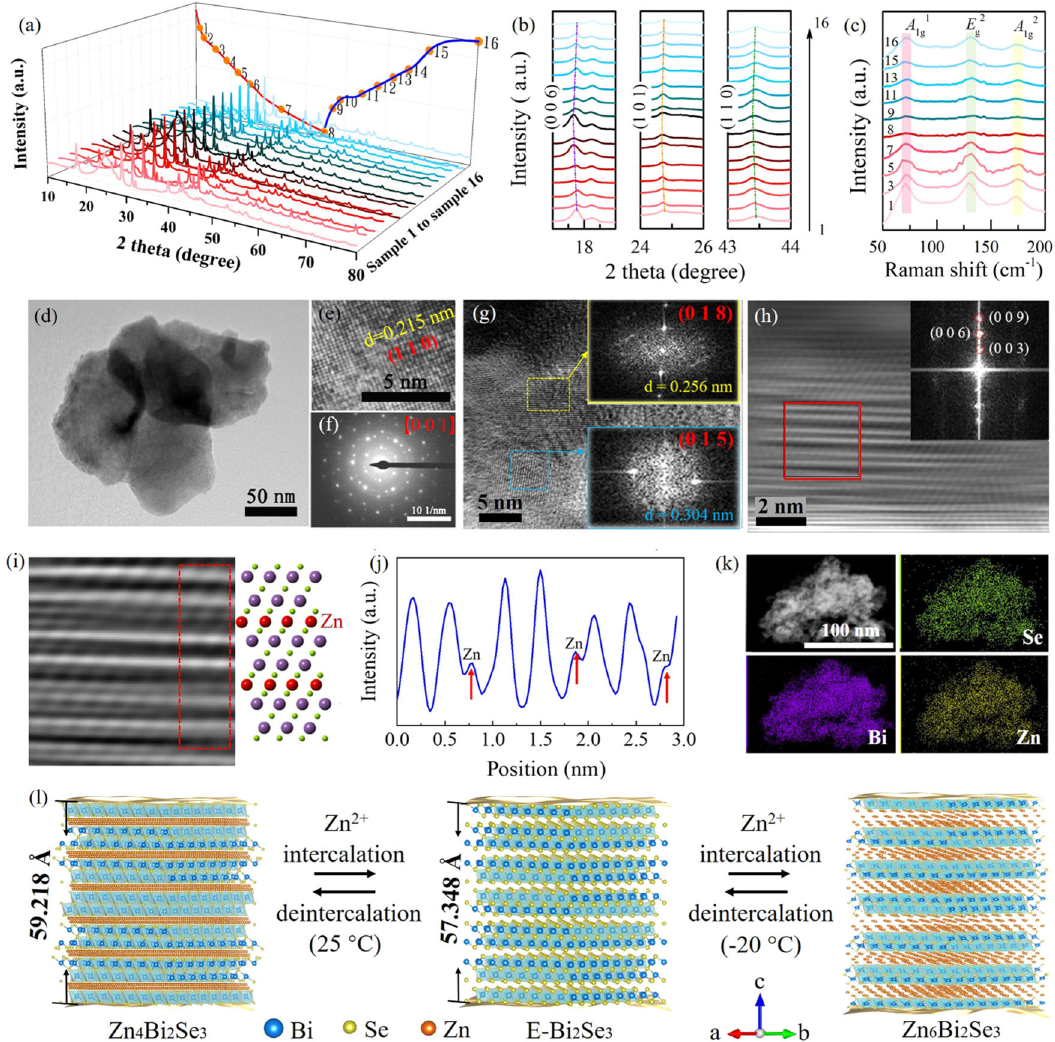
Fig. 5 Structural evolution of the E-Bi 2 Se 3 cathode during electrochemical cycling. a Evolution of ex situ XRD patterns during the charge/discharge process for E-Bi 2 Se 3 for the third cycle in the liquid electrolyte at 0.3 A g − 1 (the solid dots numbered sequentially from 1 to 16 refer to the positions at which the XRD patterns are obtained, and the red region is corresponding to the discharge process while the blue corresponding to the charge process). b Magni fi ed XRD patterns from a for 17° – 19°, 24° – 26°, and 43° – 44°. c Magni fi ed part (50 – 200 cm − 1 ) of ex situ Raman spectra of the E-Bi 2 Se 3 at the selected states corresponding to the charge/discharge process illustrated in a . d TEM image and e high-resolution TEM (HRTEM) image of E-Bi 2 Se 3 at fully discharged state after three cycles. f SAED pattern of E-Bi 2 Se 3 at fully discharged state. g HRTEM image of fully discharged E-Bi 2 Se 3 revealing (018) and (015) planes with insets displaying fast Fourier transform patterns. h HAADF-STEM image of Zn x Bi 2 Se 3 , and its corresponding FT pattern. i Magni fi ed part from the red box in h with the Zn x Bi 2 Se 3 crystal structure and j corresponding intensity pro fi le. The red arrows in j indicate the presence and speci fi c location of Zn 2 + sites. k TEM-EDS elemental maps of Bi, Se and Zn are given in colors of purple, green and yellow dots, respectively. l Schematic of Zn 2 + intercalation and deintercalation in the E-Bi 2 Se 3 cathode upon electrochemical charge and discharge process at − 20 or 25 °C. Gold sequins represent topological surface